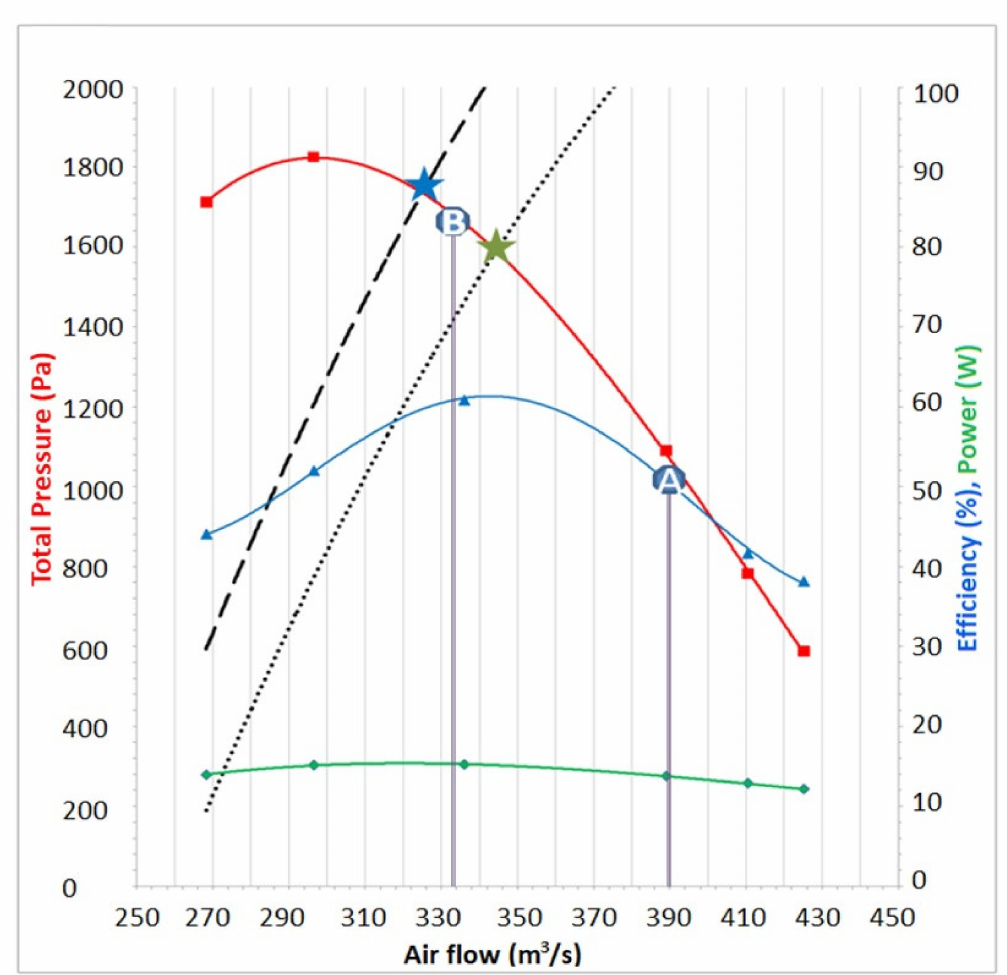
Figure 2. Cooperation of the fan with the duct in the auxiliary ventilation